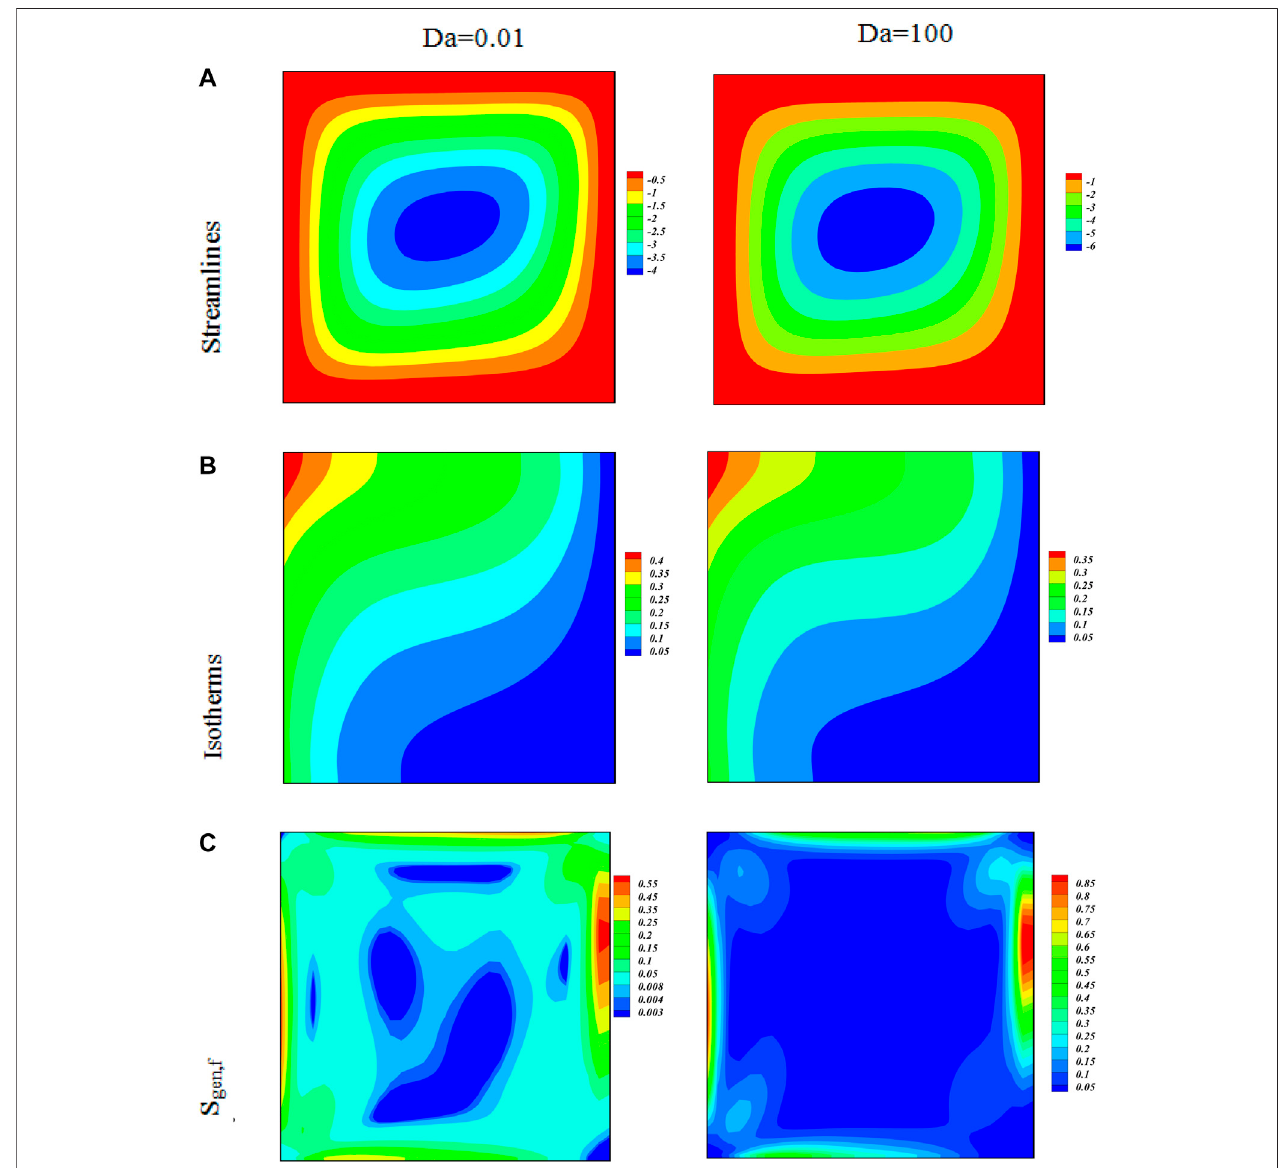
FIGURE 5 | Contour of streamlines, isotherms, irreversibility, and the Bejan Number changes at ϕ (cid:1) 0 . 04 , Ra (cid:1) 10 5 , Ha (cid:1) 1 .